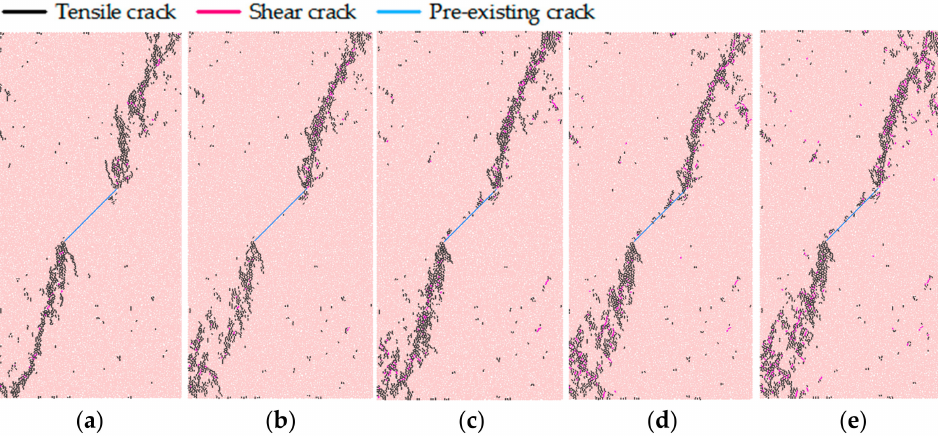
Figure 14. Cracks distribution in the main crack bearing granite at the moment of peak strength considering different confining pressures: ( a ) 10 MPa; ( b ) 20 MPa; ( c ) 30 MPa; ( d ) 40 MPa; ( e ) 50